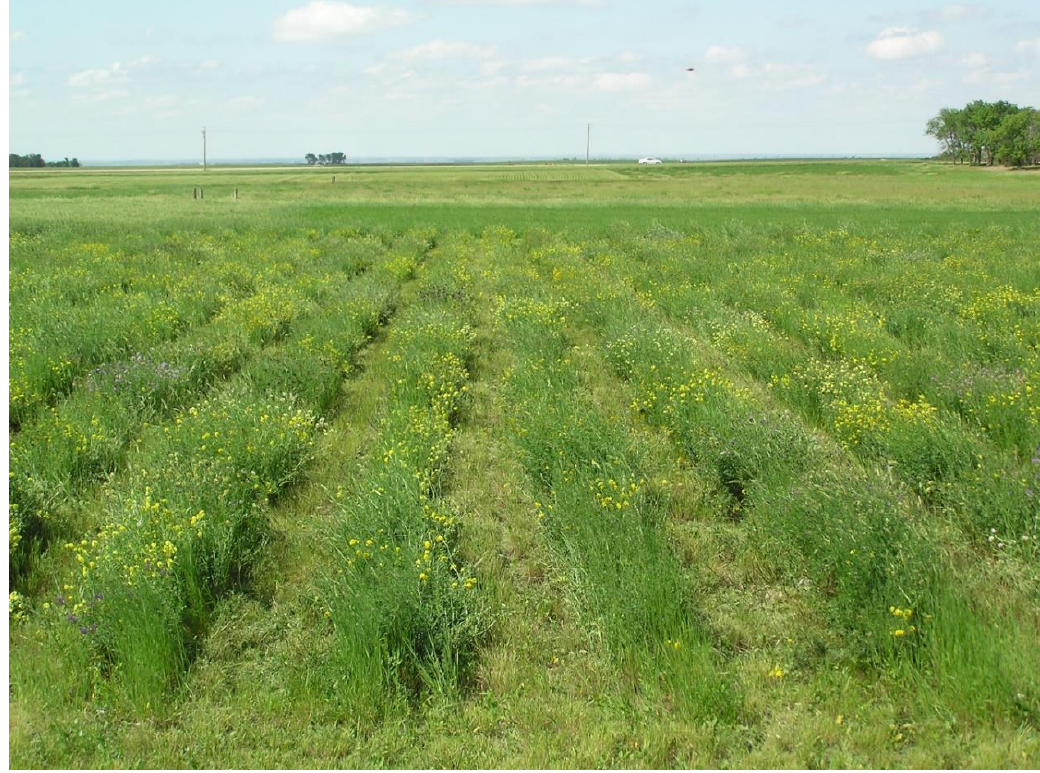
Figure 2. Half-sib family rows of the Grand River National Grassland population growing with crested wheatgrass at Highmore, South Dakota (44°31′7″ N, 99°26′28″ W).